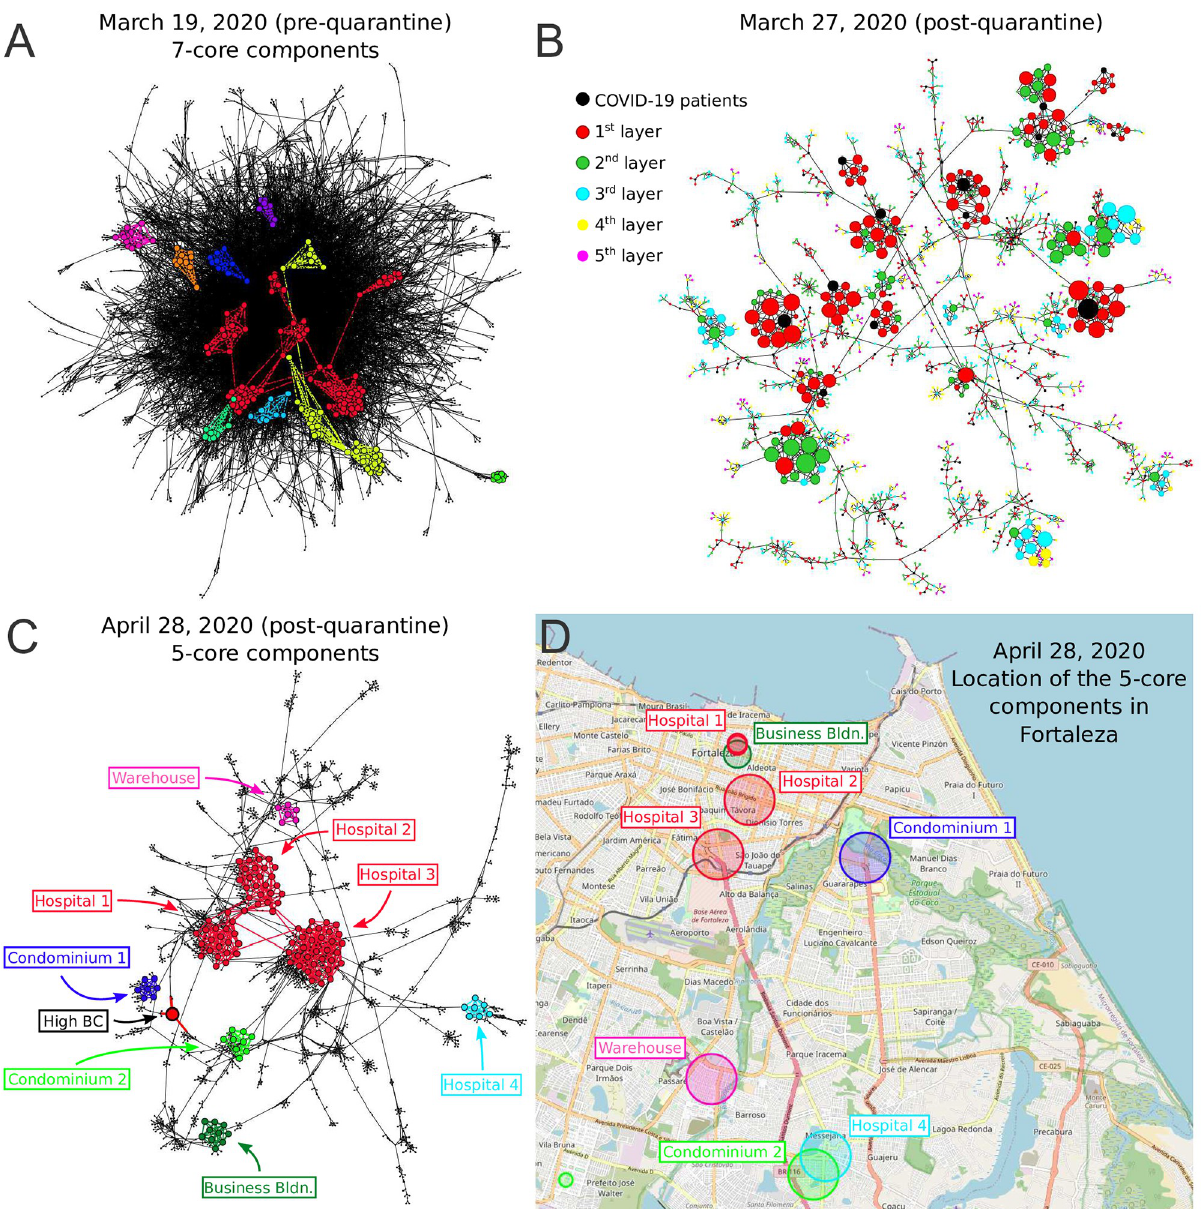
Fig 4. Evolution of GCC and k-cores over the quarantine. Disease transmission networks in the state of Ceara´ over time before and after the lockdown on March 19, 2020. (A) Transmission network on March 19 (pre-lockdown). A hairball highly-connected network is observed. The disconnected components of the 7-core ( k max ¼ 12 in this network) are colored. These components are well connected into the hairball network as core expected since mobility and connectivity is high. (B) The pre-quarantine hairball in (A) has been untangled and the k-cores have emerged 8 days into the lockdown on March 27. Here, we color the nodes according to layers of the transmission network starting at COVID-19 patient (black nodes). Size of nodes is according degree. (C) Network on April 28 including the components of the 5-core in different colors ( k max ¼ 7 for this network). Visible is core the high betweenness centrality node representing the weak-link of this k-core. (D) We plot the location of the contacts in the map of Fortaleza constituting the components of the 5-core of the April 28 in (C) . The size of the circles in the map corresponds to the number of contacts inside each location. The colors correspond to the clusters of the 5-core in (C) . The 5-core sustaining transmission is composed of clusters of contacts localized in hospitals, large warehouses and business buildings. Hospital 3, one of the largest in Fortaleza, constitutes the maximal k max ¼ 7 of the pandemic. The core underlying map comes from the Folium library of Python: https://github.com/python-visualization/folium which relies on the OpenStreetMap project [29].